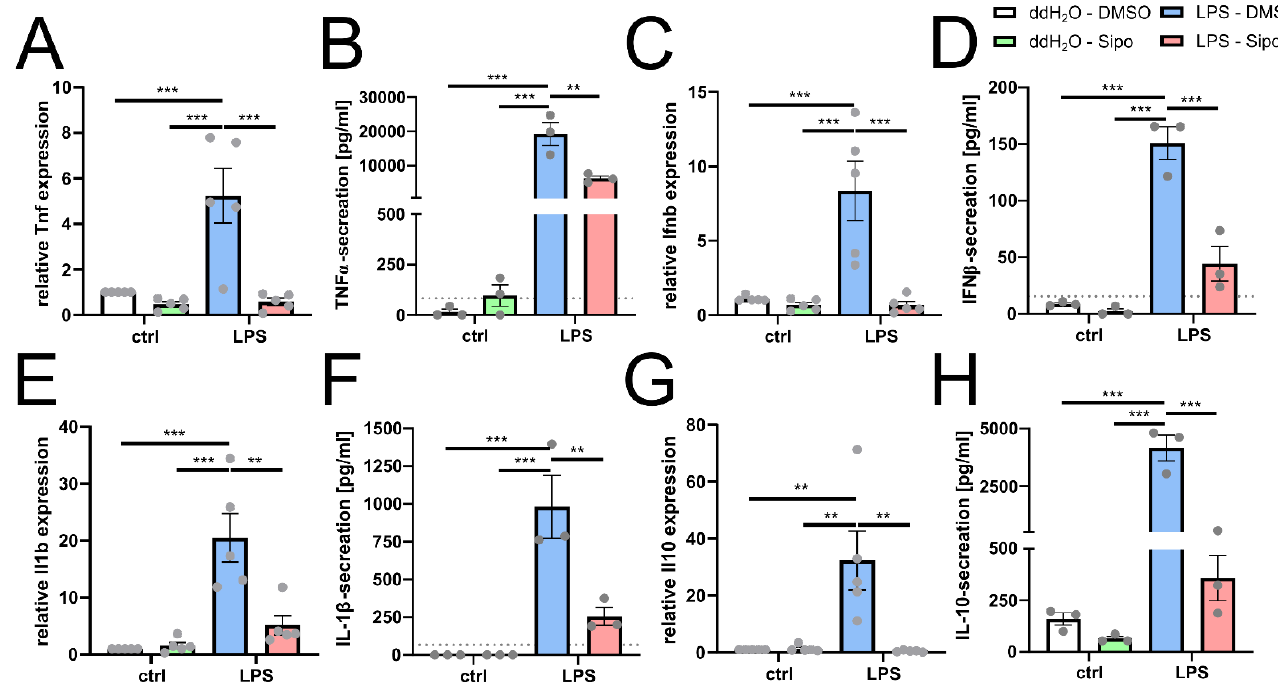
Figure 3. Siponimod modulates microglial cytokine expression and secretion in an inflammatory milieu. ( A , C , E , G ) quantitative RT-PCR analysis of Tnf ( A ), Ifnb ( C ), Il1b ( E ) and Il10 ( G ) gene expression after stimulation for 1 day with +/− 50 µM siponimod +/− LPS. ( B , D , F , H ) Quantification of TNF- α ( B ), IFNβ ( D ), IL- 1β ( F ) and IL-10 ( H ) protein concentration in the cell culture medium of microglial cells stimulated for 3 days with +/− 50 µM siponimod +/− LPS using respective quantitative sandwich ELISA assays. Grey-dotted lines indicate the lowest standard of the ELISA kit: TNF α = 82.3 pg/mL, IFN β = 15.63 pg/mL, IL-1 β = 68.59 pg/mL and IL-10 = 8.23 pg/mL. Data are presented as mean values ± SEM. Grey dots represent individual data points. Significance of gene expression analysis as well as ELISA was assessed by 1-way analysis of variance (ANOVA) followed by Tukey’s post hoc test using Graph-Pad Prism 8.4.3 (GraphPad Software, San Diego, CA, USA). The experimental groups were considered significantly different at ** p < 0.01, *** p < 0.001.